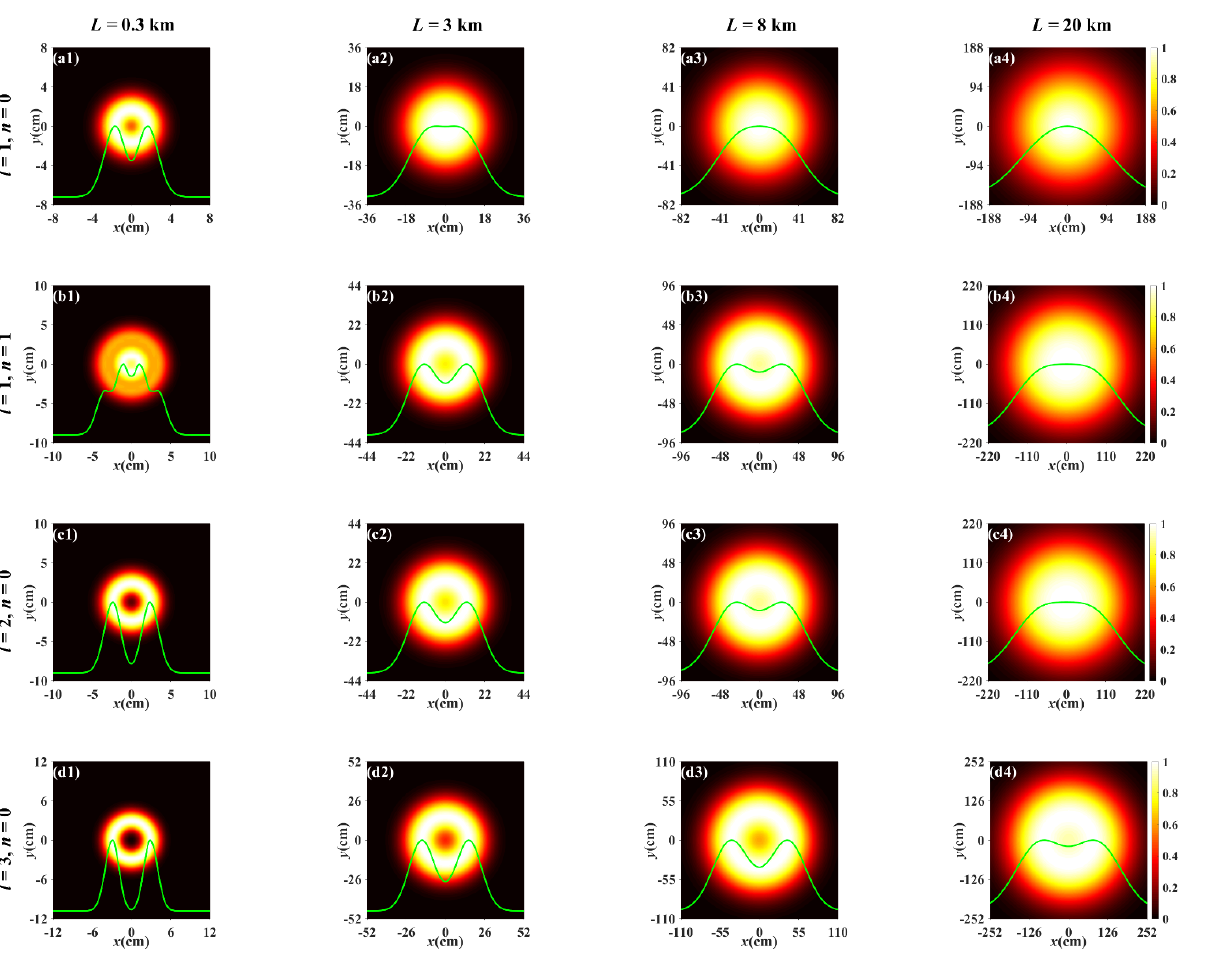
Figure 5. Normalized spectral intensity distribution of the PCTLGP beam at several propagation distances in anisotropic turbulence for different mode orders and topological charges ( ξ x = ξ y =